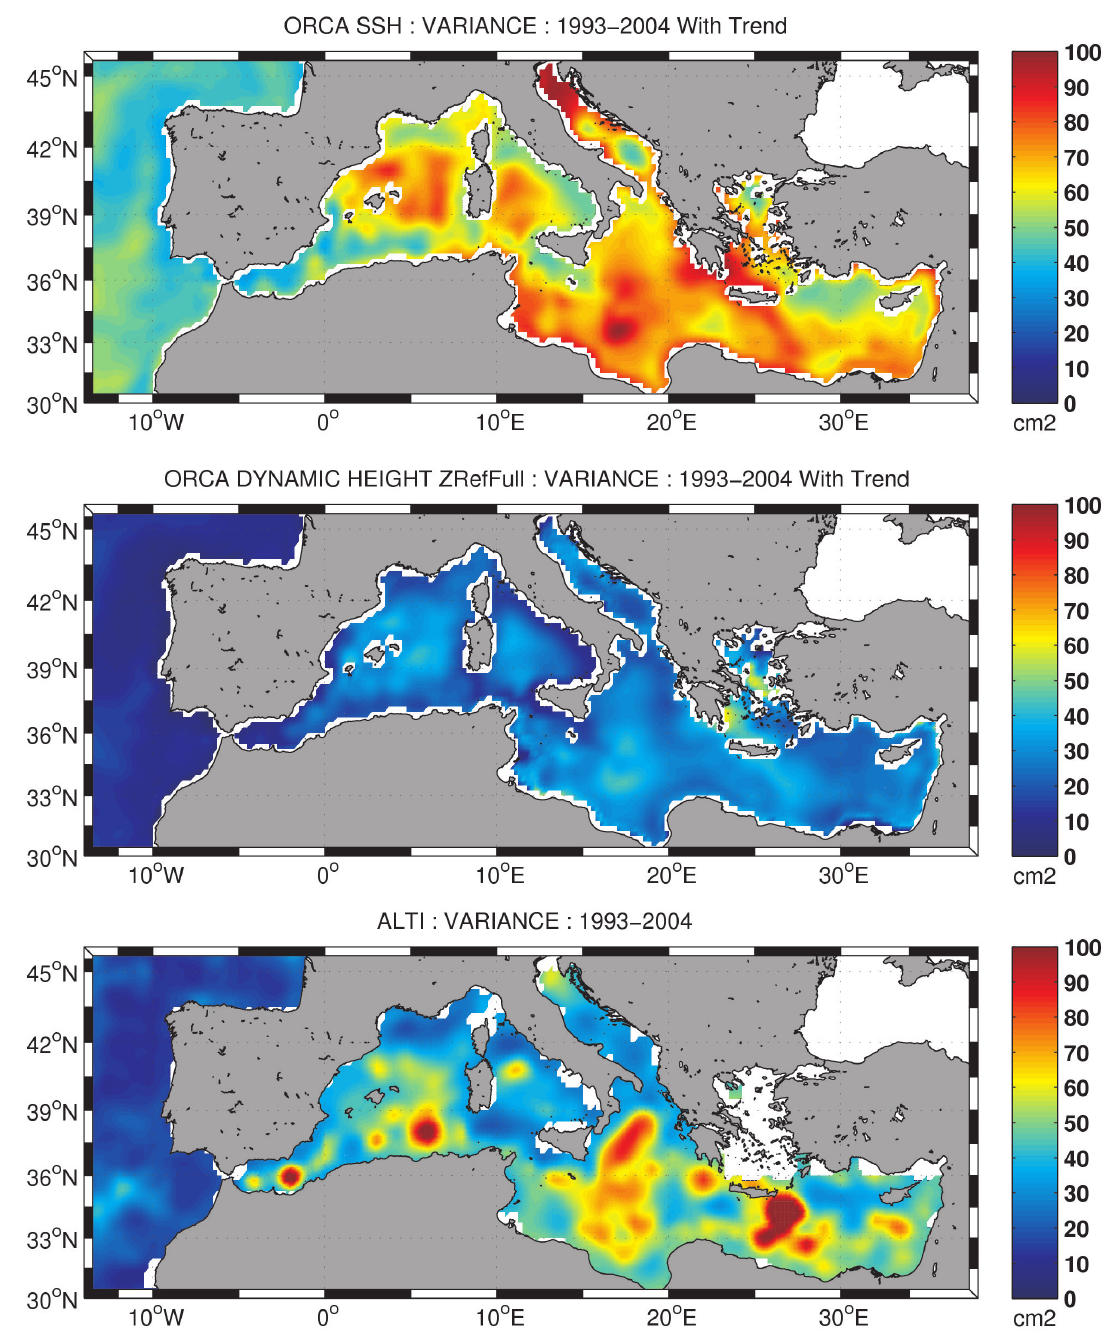
Fig . 7. – ORCA steric height (top), ORCA sea surface height (middle), and altimetry (bottom) variance maps for the 1993-2004